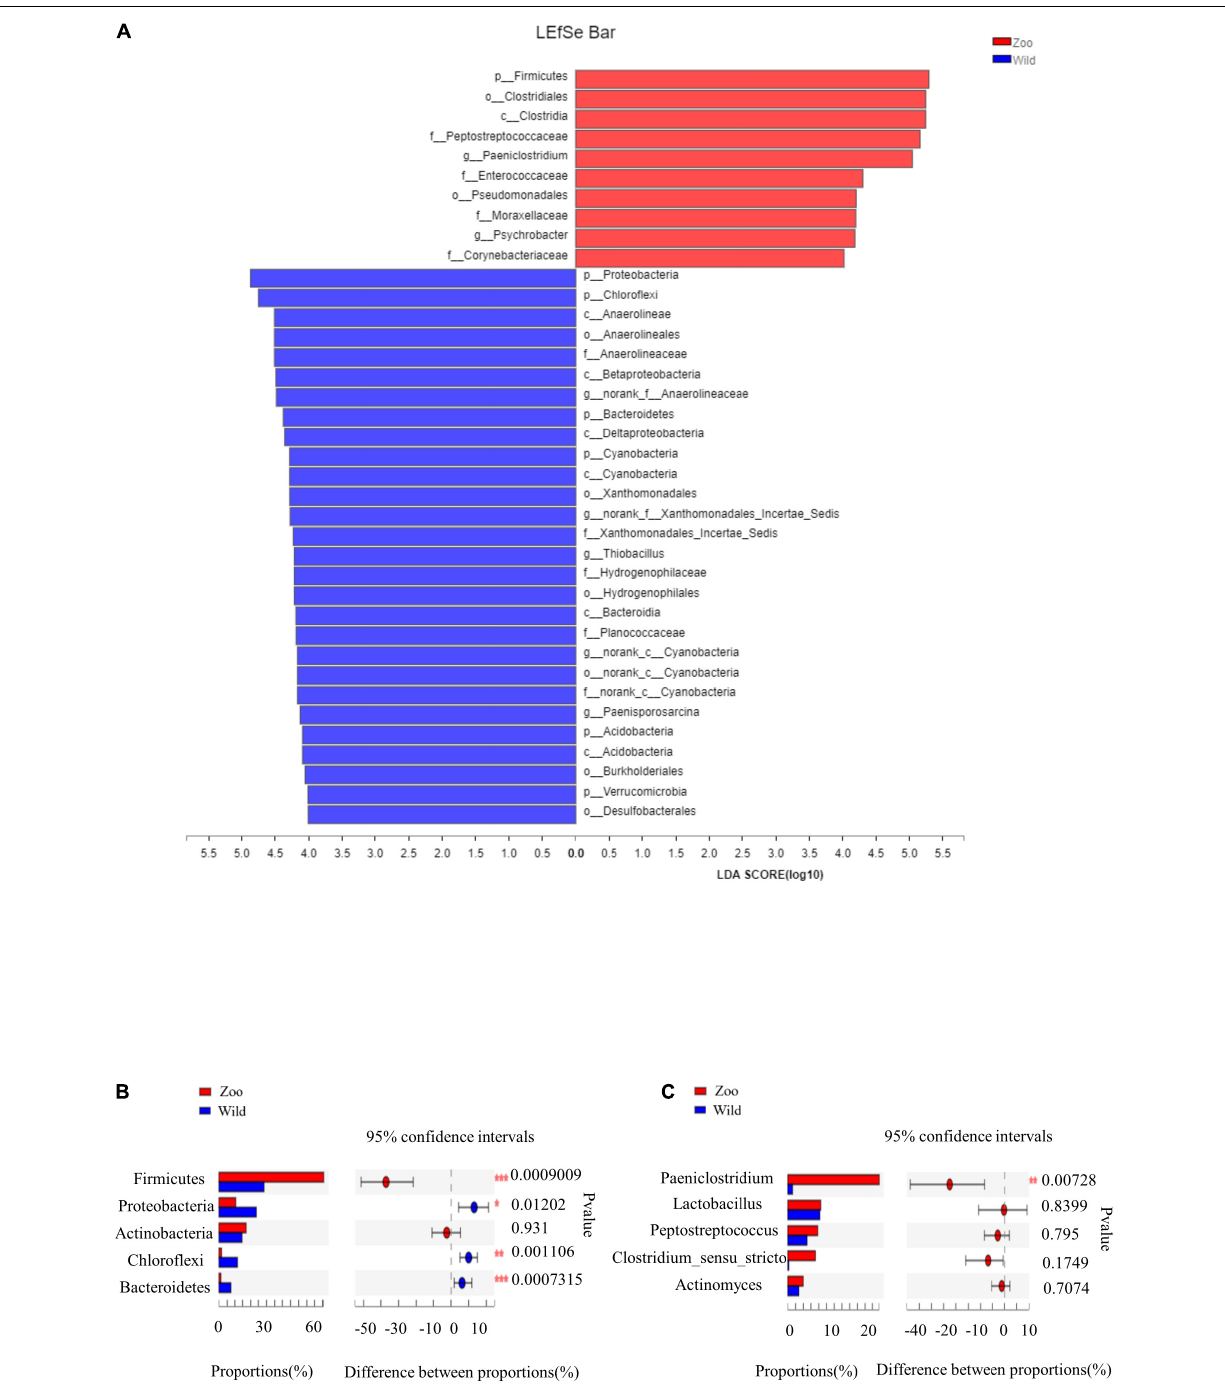
red-crowned cranes and black-necked cranes at the phylum level, while Firmicutes was the predominant phylum (Xie et al., 2016; Wang et al., 2020). Comparison of the relative abundance of gut microbiota in C. boyciana between Z group and W